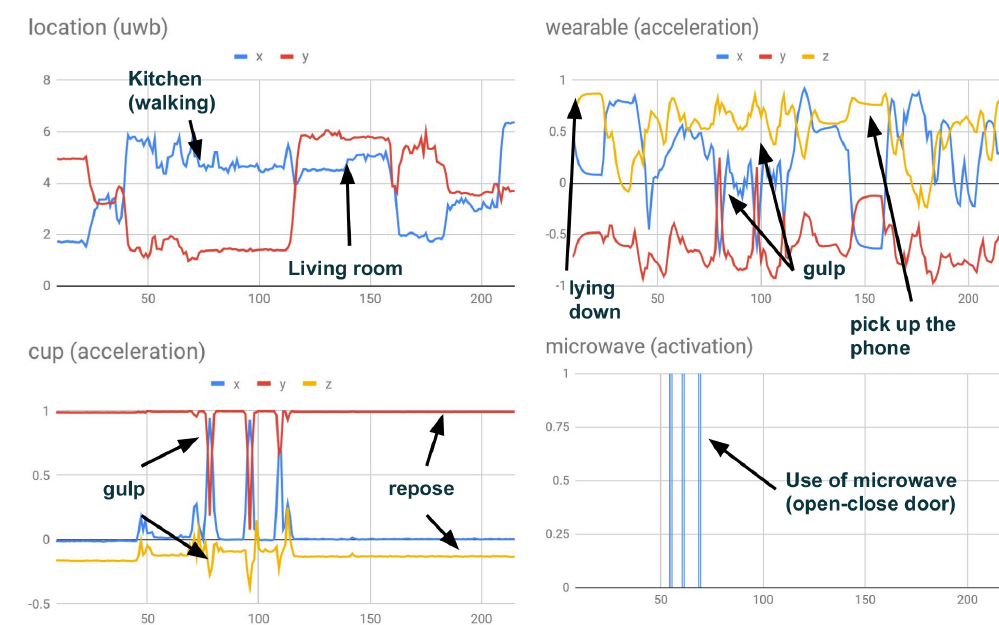
Figure 6. Data from heterogeneous sensors. The top-left shows the location in meters from a UWB device. The top-right shows acceleration from a wearable device. The bottom-left shows acceleration in the inhabitant’s cup. The bottom-right shows the activation of the microwave. Some inhabitant behaviors and the impact on sensors are indicated in the timelines.